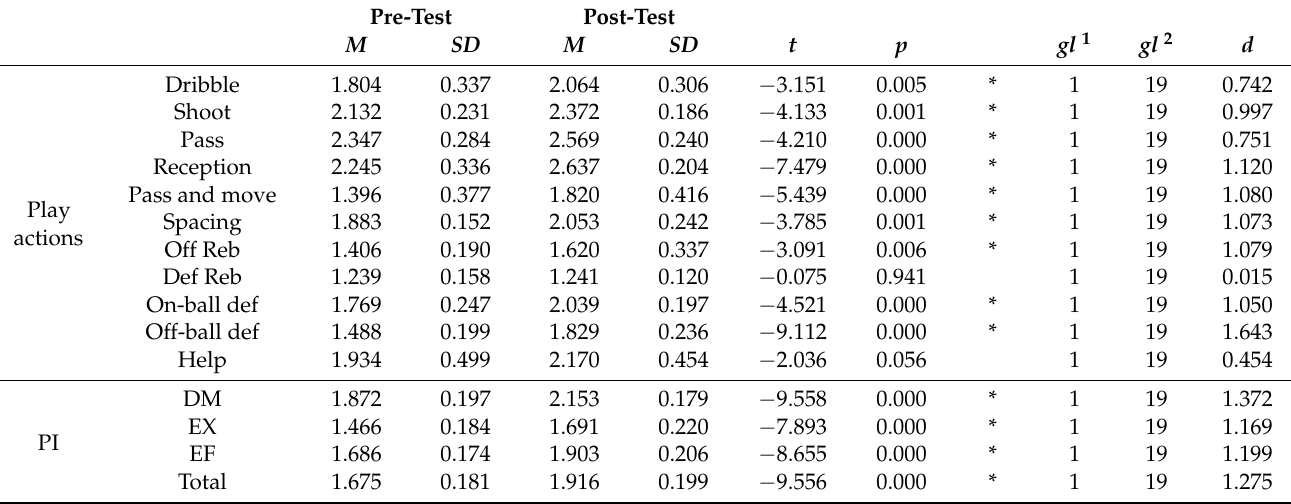
Table 5. T -test for related samples in the TGB